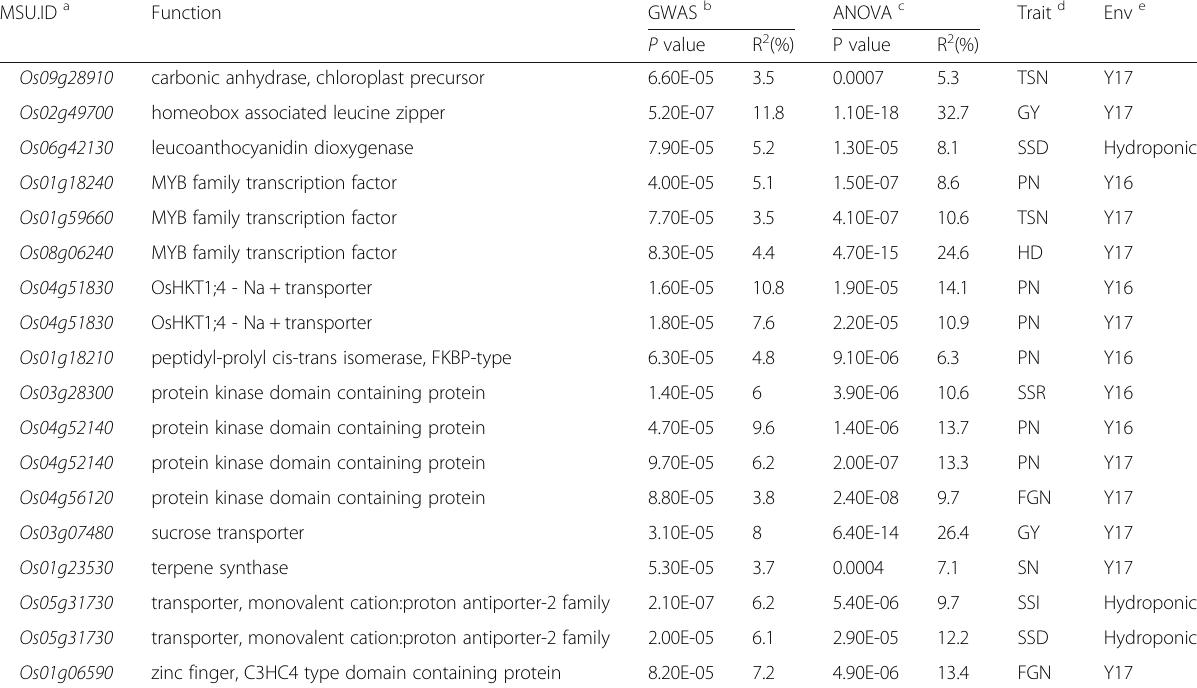
Table 4 Fifteen promising candidate genes for rice salt tolerance and their associations with the targeted traits identified by haplotype